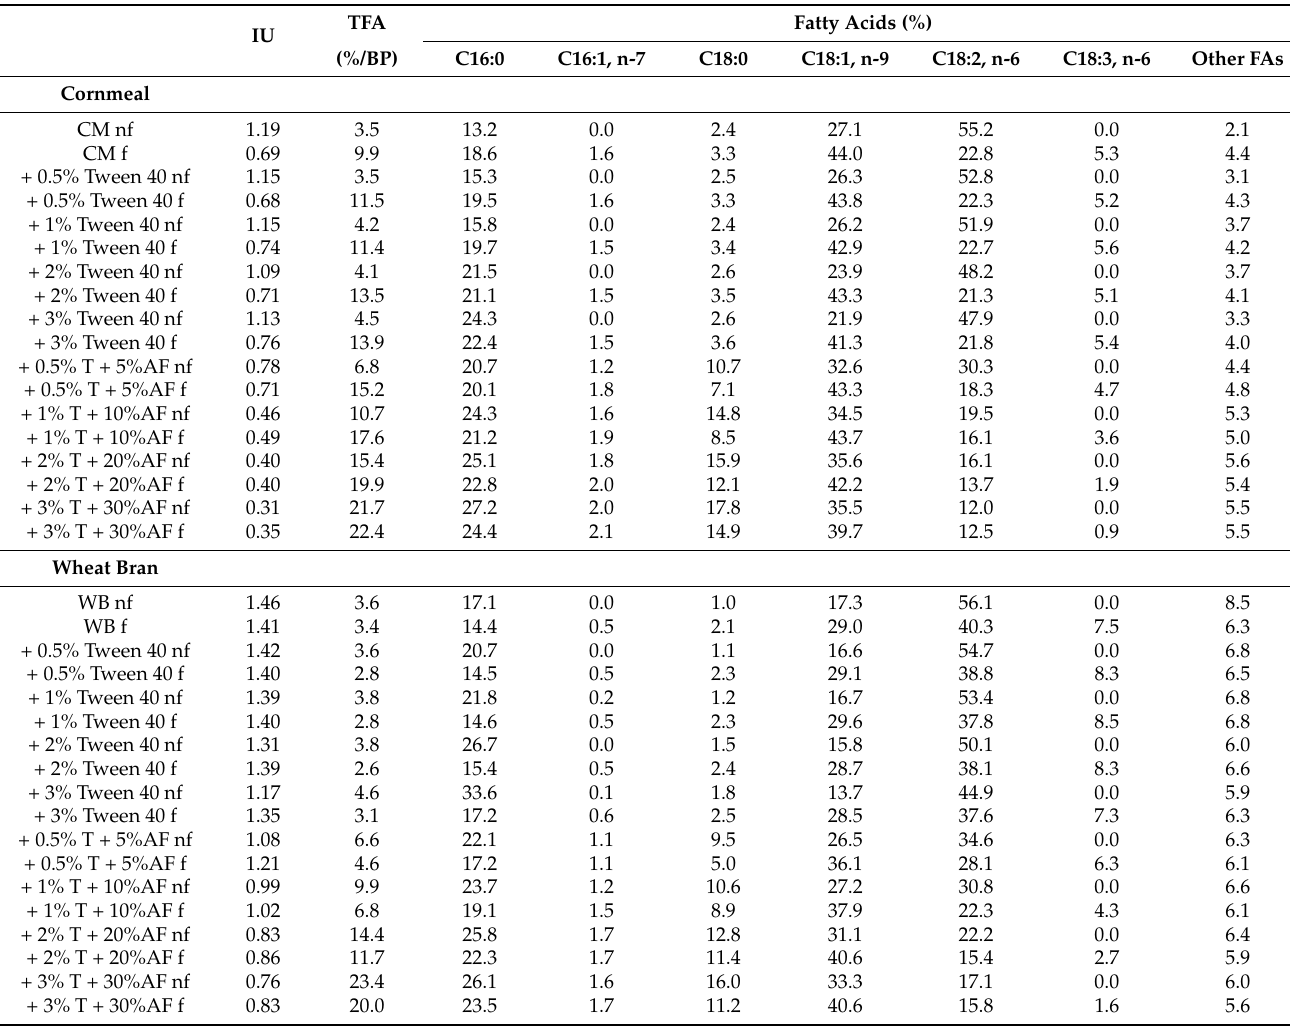
Table 4. Percentual main fatty acids composition, total fatty acid content (TFA), and index of unsaturation (IU) of non- fermented (nf) and fermented (f) SSF substrates (cornmeal—CM, wheat bran—WB) with the addition of different amounts of Tween ® 40 (T) and animal fat material (AF). The results are an average of three independent biological replicates with α <